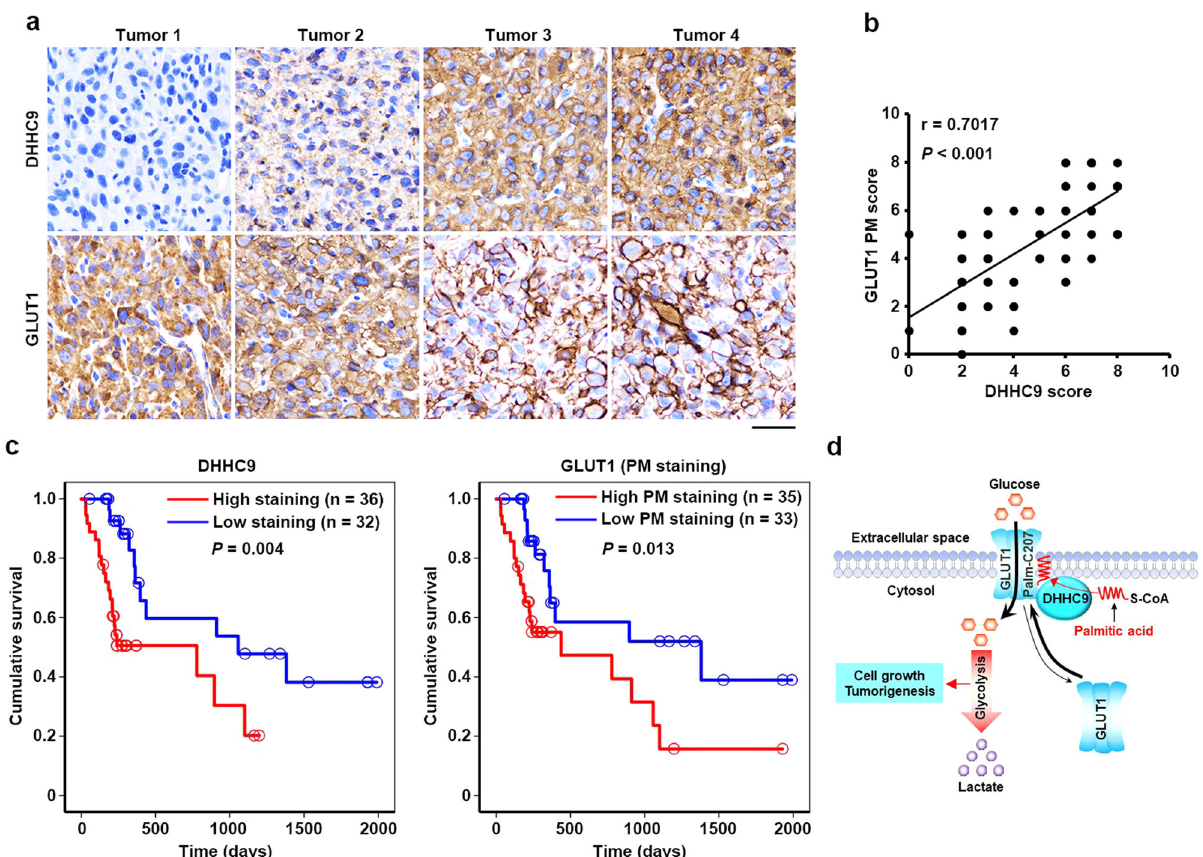
Fig. 6 DHHC9 expression positively correlates with GLUT1 PM localization in GBM specimens and indicates clinical aggressiveness of GBM. a , b Sixty- eight human primary GBM specimens were immunohistochemically stained with indicated antibodies. Representative photos of tumors are shown ( a ). Immunohistochemistry staining scores of DHHC9 and PM-localized GLUT1 were analyzed by the two-tailed Pearson correlation ( b ). Note that some of the dots on the graphs represent more than one specimen (i.e., some scores overlapped). c Kaplan – Meier method was used to plot survival curves in human GBM specimens ( n = 68) with high (5 – 8 staining scores, red curve) and low (0 – 4 staining scores, blue curve) levels of DHHC9 and PM-localized GLUT1. The two-tailed log-rank test was used to compare the overall survival rate. Empty circles represent censored data from patients alive at the last clinical follow-up. d A mechanism of S-palmitoylated GLUT1-dependent glycolysis. GLUT1 Cys207 palmitoylation catalyzed by DHHC9 resulted in PM localization of GLUT1, leading to enhanced uptake of glucose, thereby promoting glycolysis, cell growth, and GBM tumorigenesis. P values were calculated by the two- tailed Pearson correlation ( b ) and the two-tailed log-rank test ( c ). Scale bar, 20 μ m ( a ). Source data are provided as a Source Data fi